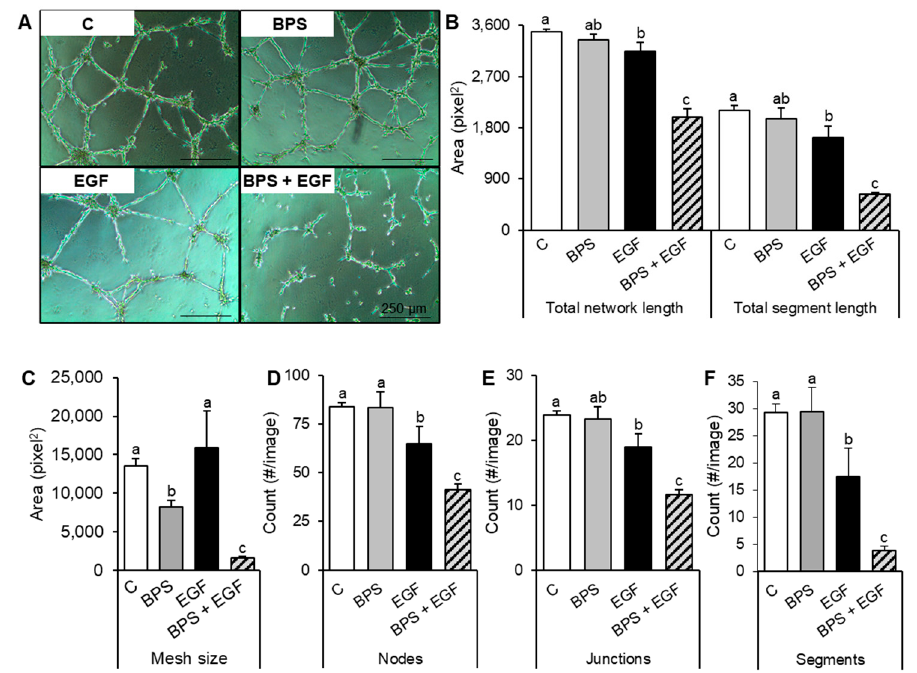
Figure 6. Effects of BPS on endovascular differentiation in trophoblast cells. ( A ) Representative images of HTR-8/SVneo cells were seeded in Matrigel and exposed for 18 h to the control (C; 0.1% DMSO), BPS (1000 ng/mL), EGF (30 ng/mL), or BPS (1000 ng/mL) + EGF (30 ng/mL) groups. ( B – F ) Quantification of tube formation parameters (mean ± SEM): ( B ) total network length and total segment length expressed as an area (pixel 2 ), ( C ) mesh size expressed as an area (pixel 2 ), ( D ) nodes expressed as the number of nodes per area, ( E ) junctions expressed as the number of junctions per area, ( F ) segments expressed as the number of segments per area. A generalized linear model was used compare treatments. Different letters denote statistical differences among treatment groups at p < 0.05 ( n = 4 technical replicates/group).